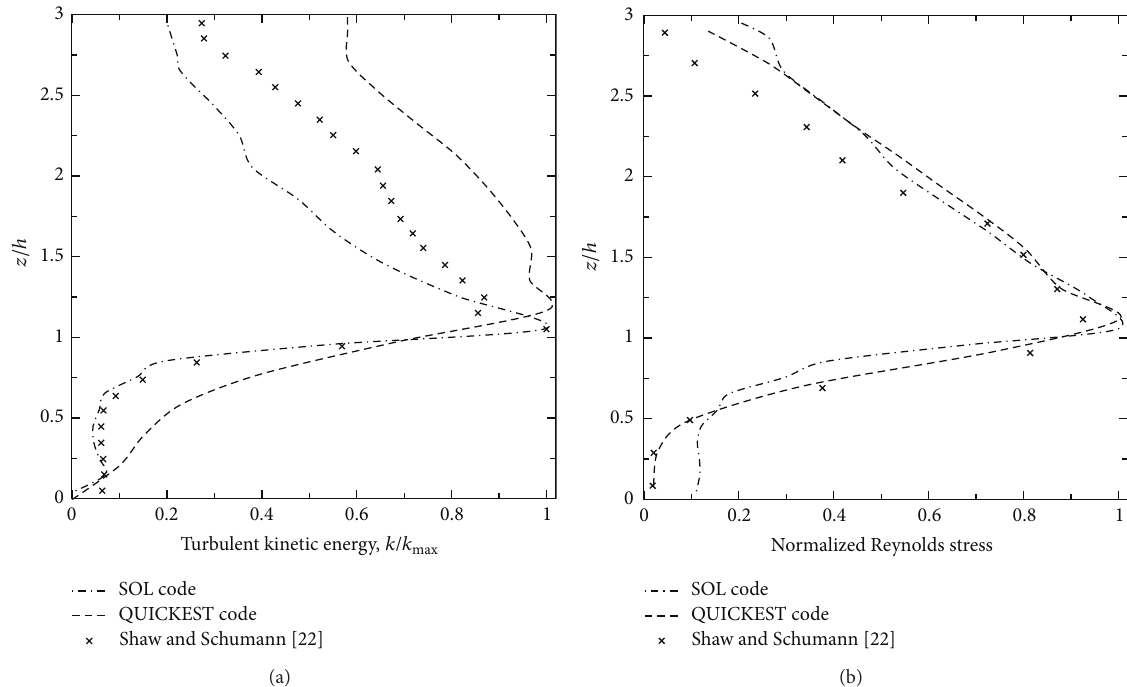
Figure 3: Vertical profile of the turbulent kinetic energy (a) and of the Reynolds stress (b) for a leaf area index equal to 5.